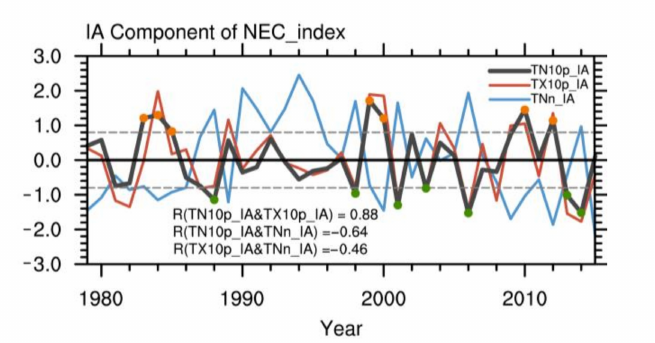
Figure 4. Standardized IA components of TN10p (black line), TX10p (red line) and TNn (blue line). The gray dashed lines represent ± 0.8 standard deviations. The solid orange (green) dots denote positive years above 0.8 standard deviations or negative years below − 0.8 standard